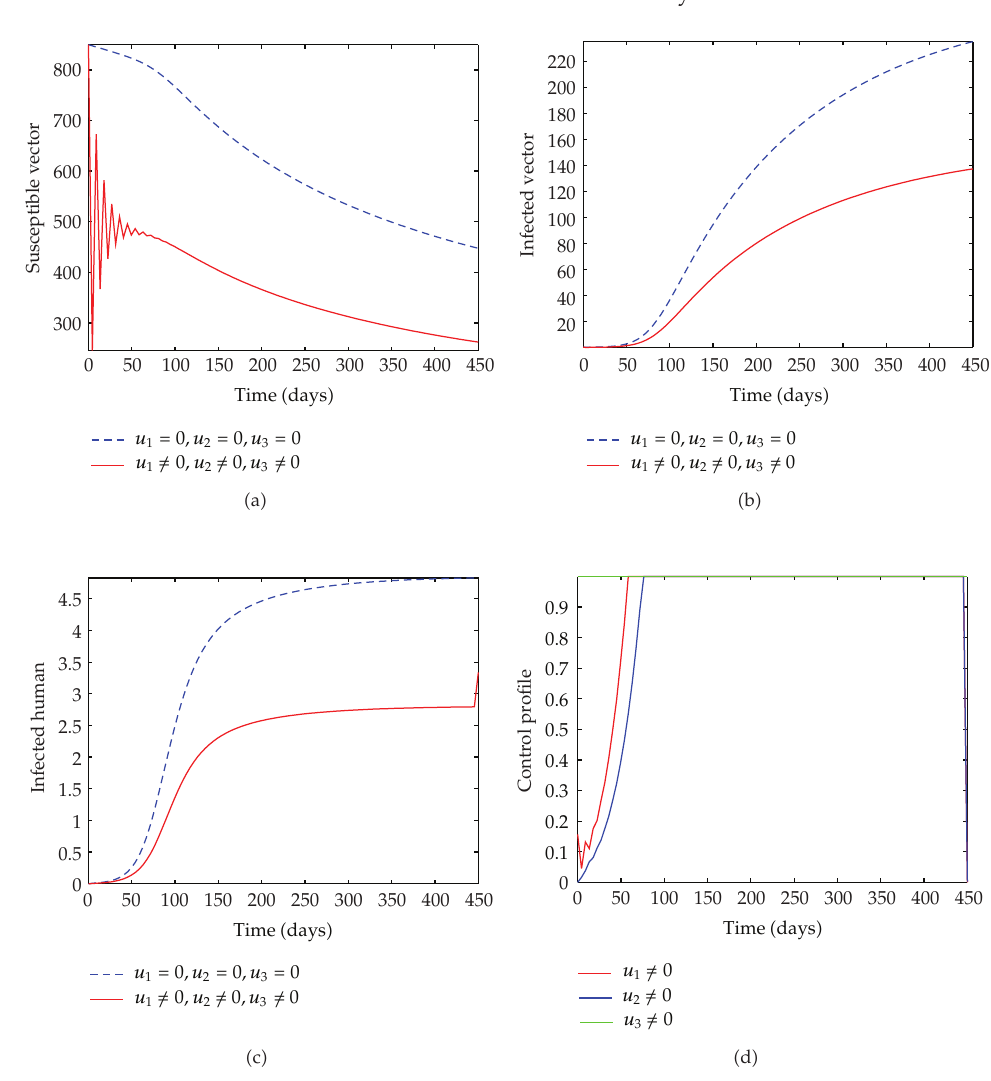
Figure 4: Simulations of the malaria model showing the e ff ect of control strategies on malaria